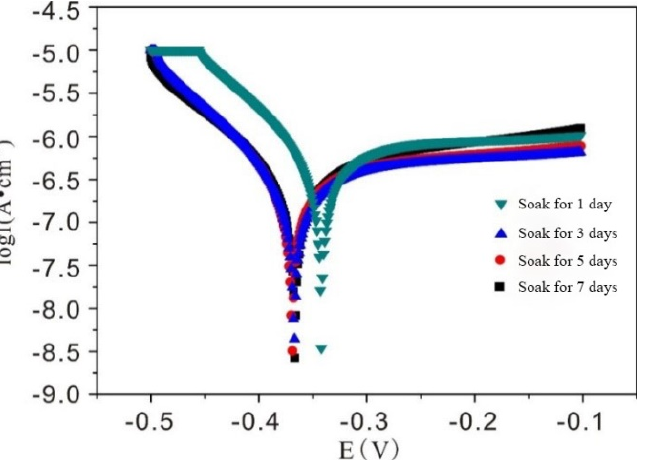
Figure 12. Tafel curves of 3D-printed + modified samples immersed in simulated seawater for different times. Table 3. Corrosion characteristics parameter table of 3D-printed + modified samples immersed in simulated seawater for different time.